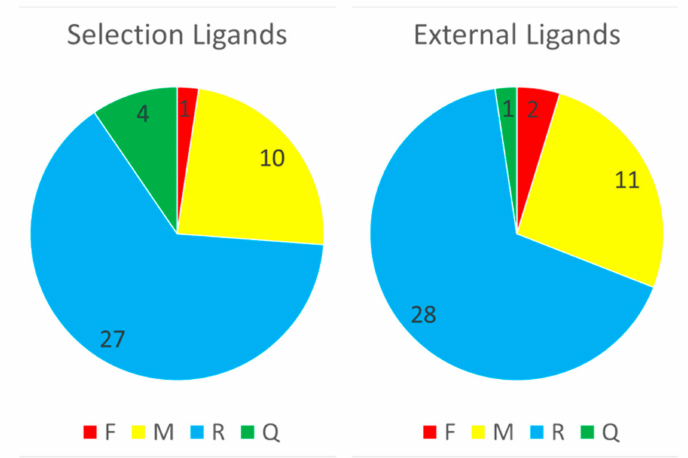
Figure 9. RMSD prediction success counts-by preestablished categories F, M, R, Q–for selection and external ligands, using the RMSD landscape on the Hy map. Numeric labels are numbers of ligands